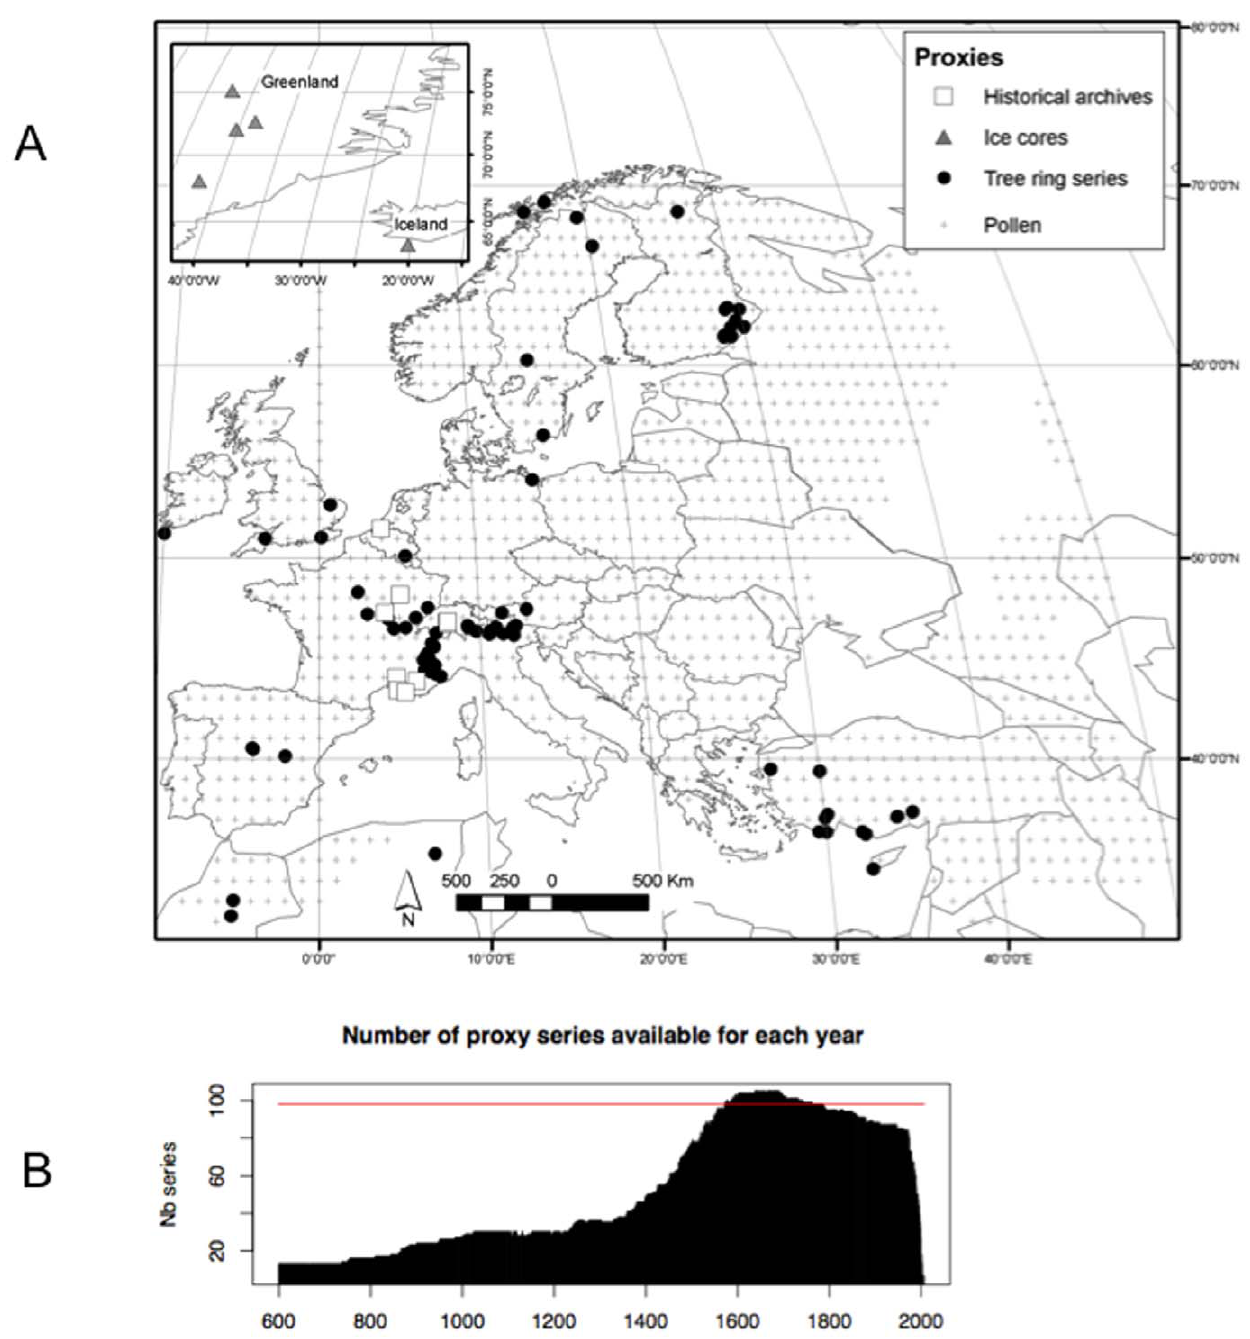
Figure 1. Characteristics of the proxies. A) Map of the proxies used. B) Number of proxy series available as a function of the year, from 600 to 2007.